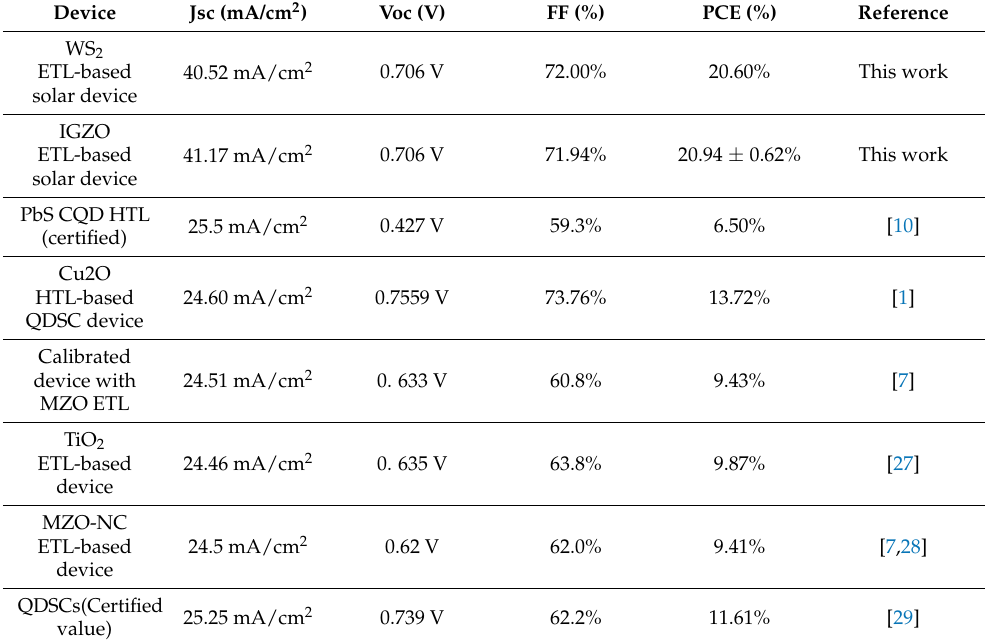
Table 4. Photovoltaic parameters of the device having WS 2 as ETL, IGZO as ETL, and the certified device